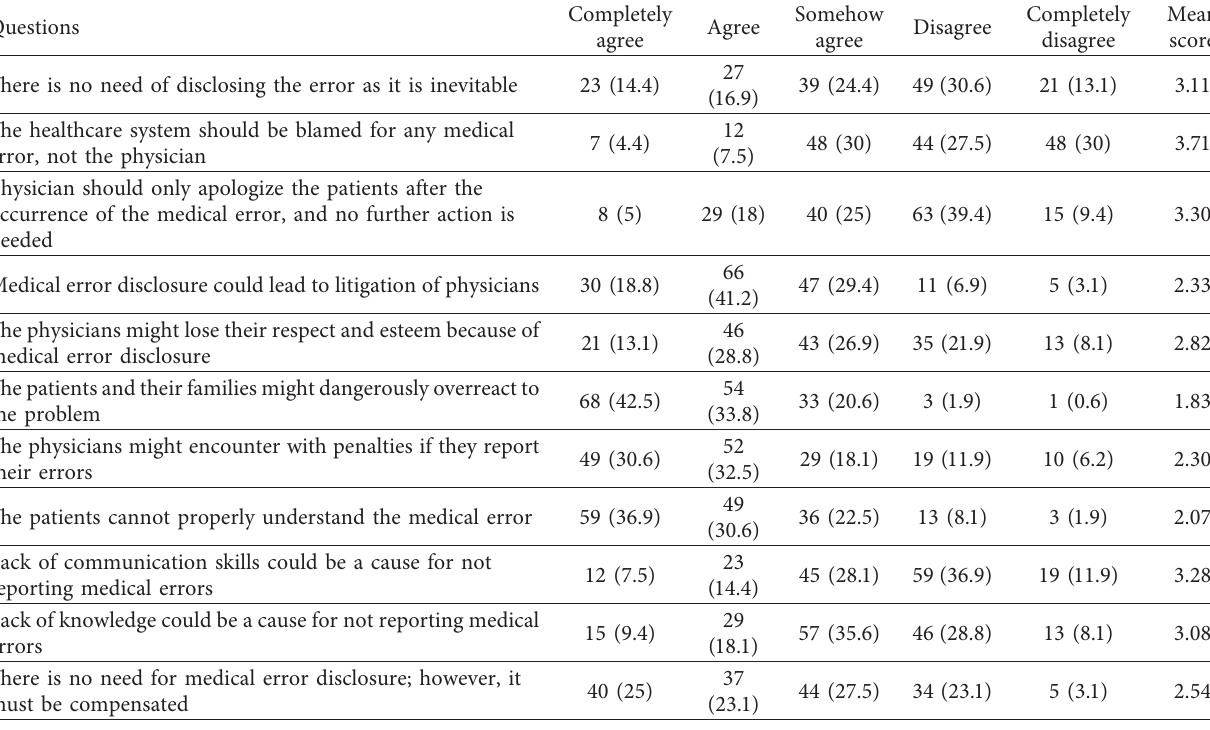
Table 6: Reasons for not disclosing medical errors.